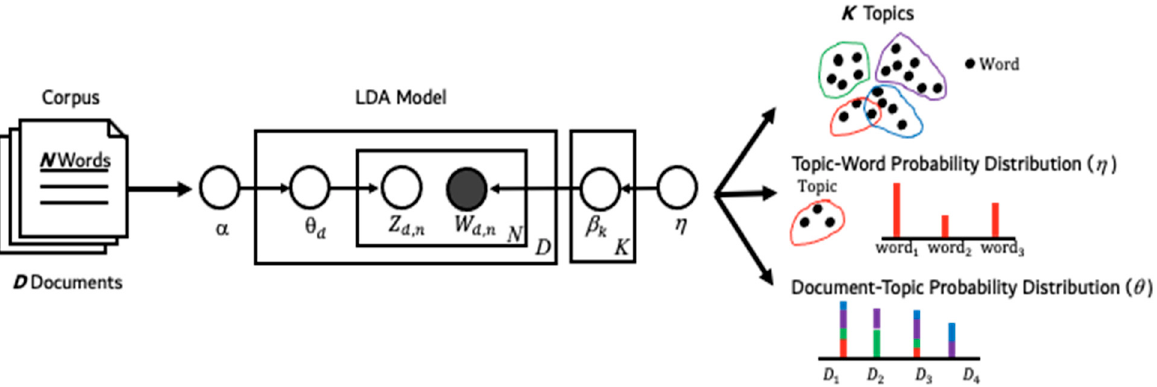
Figure 1. Graphical model for the LDA process adapted from Blei [13]